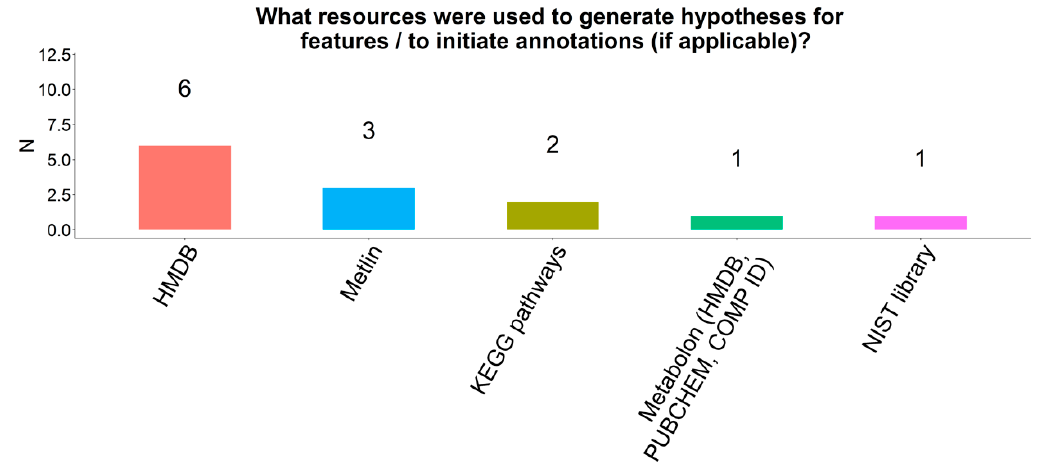
Figure 7. Strategies for metabolite annotation among participating COMETS cohorts.